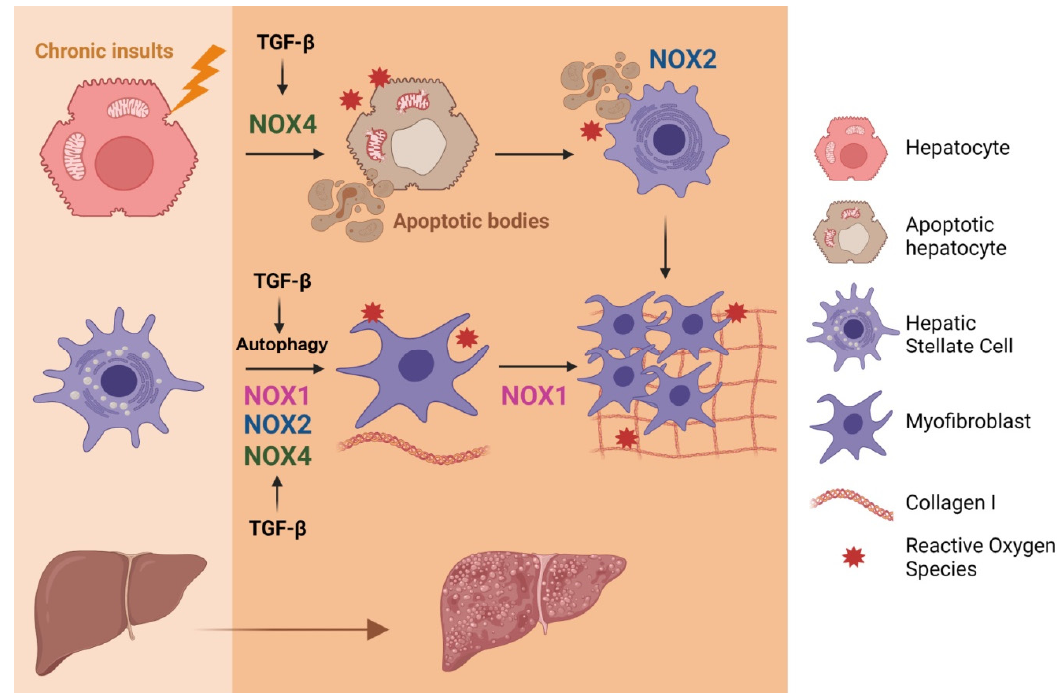
Figure 4. Involvement of the axis TGF- β /NOX in liver fibrosis. Activation of different NOXs by TGF- β contribute to activation of HSC towards MFB, the cells responsive for extracellular matrix proteins deposition. TGF- β -induced NOX4 mediates hepatocyte apoptosis. Apoptotic bodies are phagocytosed by HSCs, a process that requires NOX2, which also contributes to their proliferation and activation towards MFBs. Figure was created with BioRender.com (accessed on 12 July 2021).